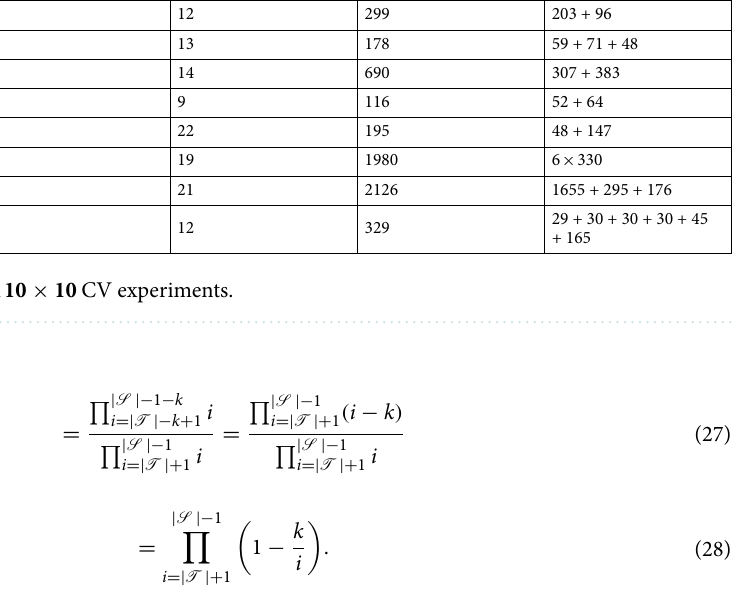
Table 3. datasets analyzed in 10 × 10 CV experiments.